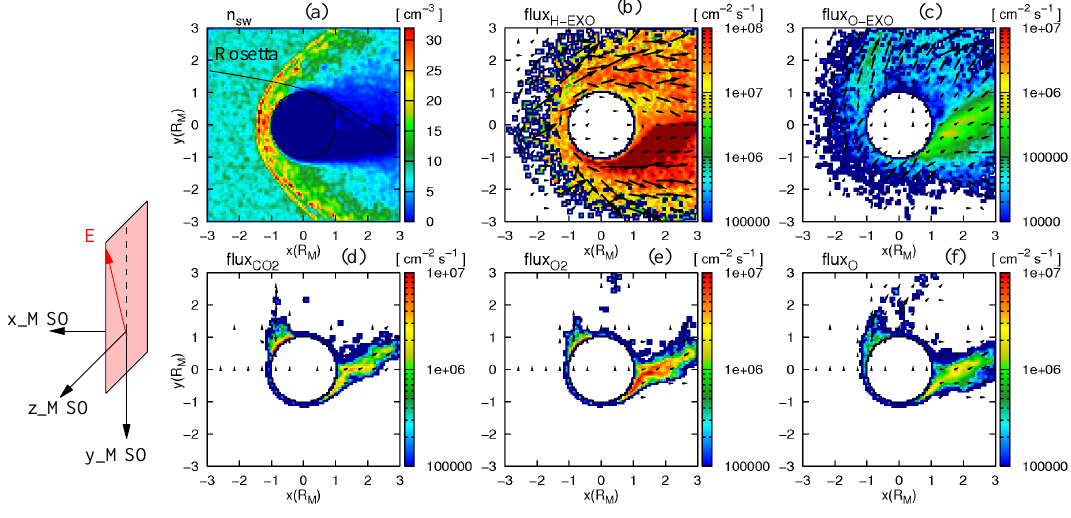
Fig. 7. Contour plots in the equatorial plane from a hybrid simulation. Solar wind density (a) and ion flux values (b–f) are presented. Panel (a) shows the solar wind density ( n sw ) , panel (b) the particle flux of H + ions originating from the hydrogen exosphere (flux H − EXO ), panel (c) shows the particle flux of O + ions originating from the oxygen exosphere (flux O − EXO ), panels (d),(e) and (f) show the particle flux of CO + , O + and O + ions, respectivally (flux CO2 , flux O2 , flux O ). The convective electric field vector lays in the plane y-z-plane. The 2 2 projection of Rosetta’s trajectory is shown in panel (a). In front of Mars a bow shock is formed, which shows a two-shocklet structure. The solar wind gets strongly mass-loaded by ionospheric and exospheric heavy ions (b–f). Exospheric oxygen ions are picked up by the solar wind electric field (c). In the wake region of the planet plasma cloud structures are detached from the ionosphere and are dragged away into the tail (d–f).